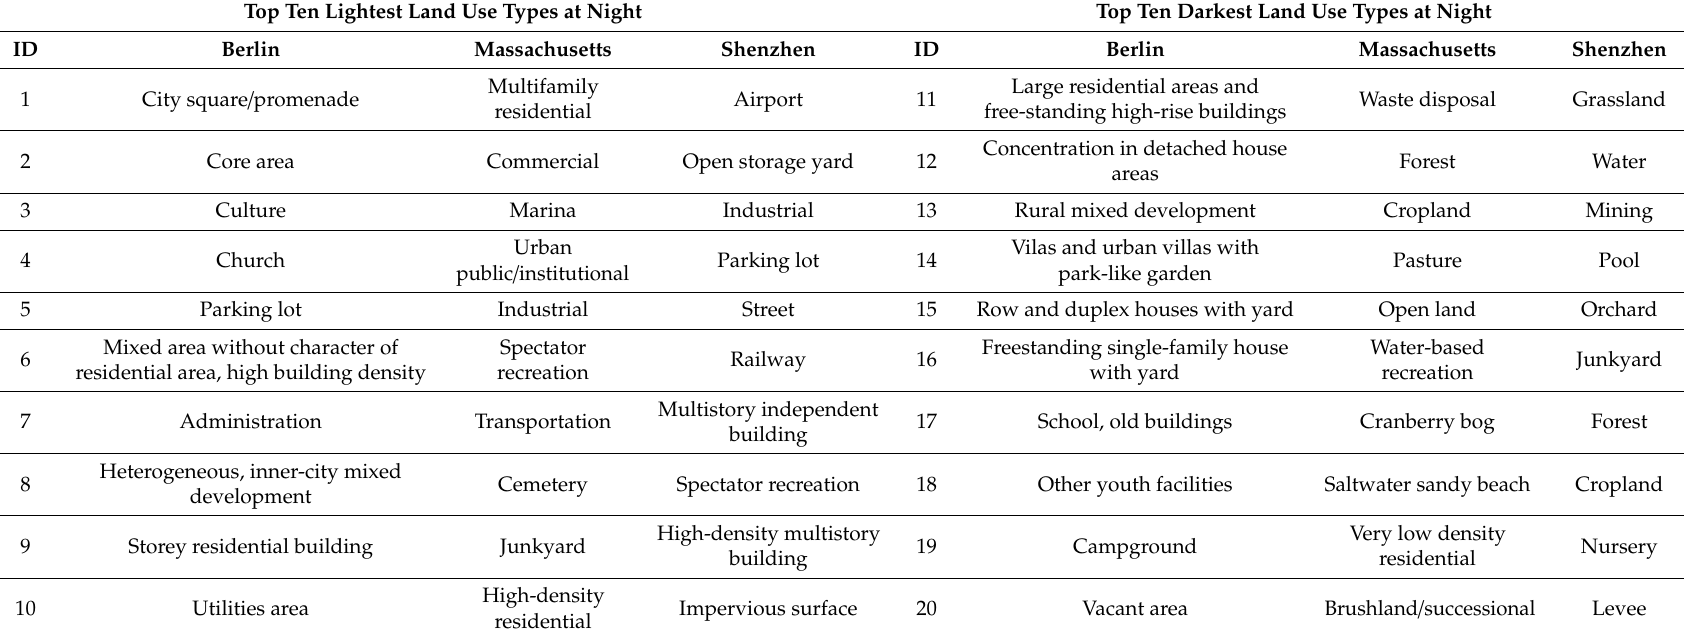
Table A5. Top ten lightest and darkest land use types at night in the three study areas. Top Ten Lightest Land Use Types at Night Top Ten Darkest Land Use Types at